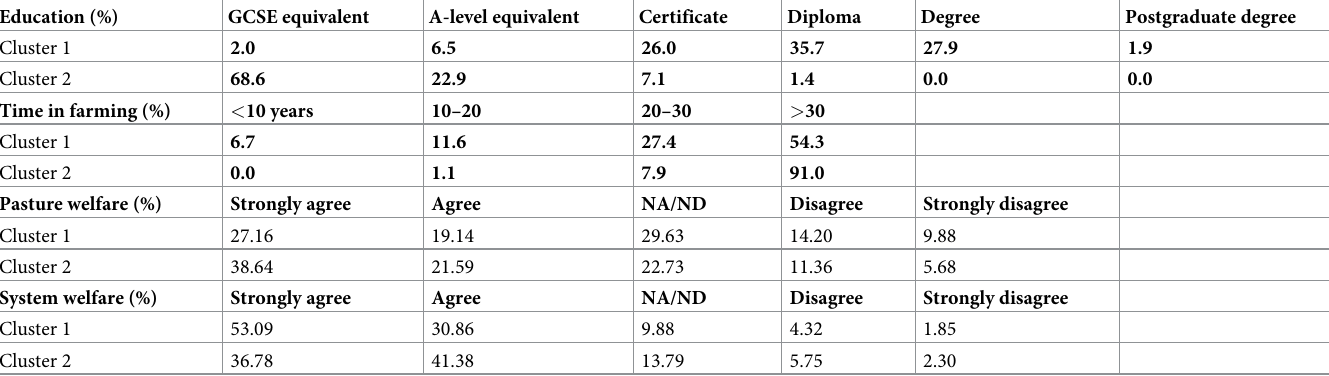
Table 2. Pasture and system welfare responses according to cluster membership (% � ).